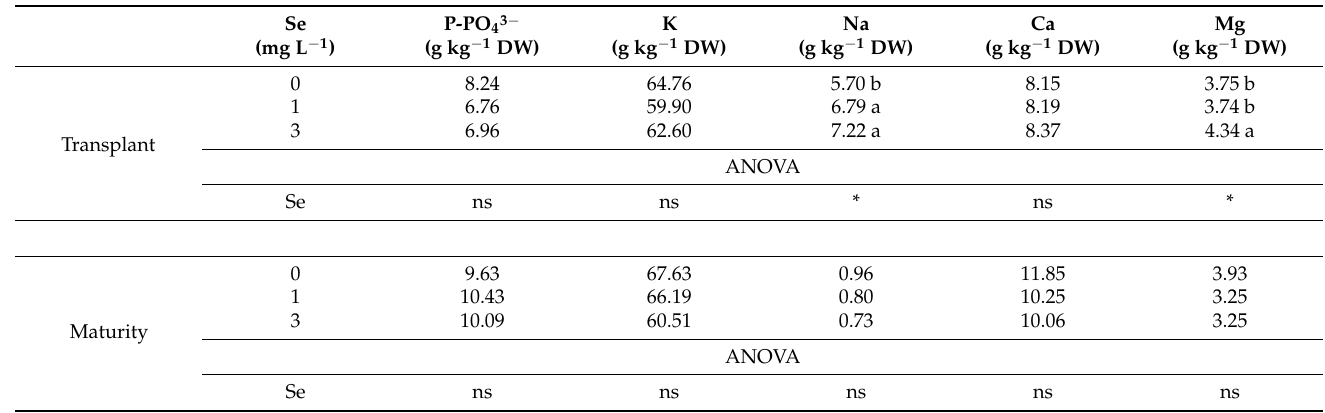
Means ( n = 3) flanked by the same letter are not statistically different for p = 0.05 after Tukey’s test. Significance level: * p ≤ 0.05; ns = not significant. The exposure of lettuce seedlings to 3 mg Se L − 1 led to a lower leaf total chlorophyll content ( − 16.6%) (Figure 3A), and a higher antioxidant capacity (+21.7%) and flavonoid content (+6.10%) (Figure 4A,C).